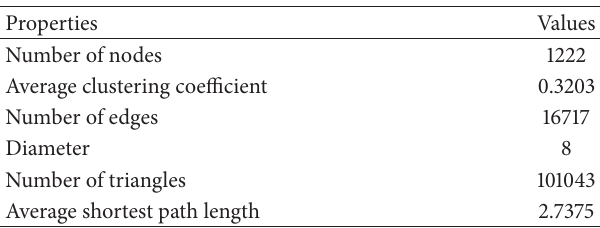
Table 2: Political Blogs dataset properties.